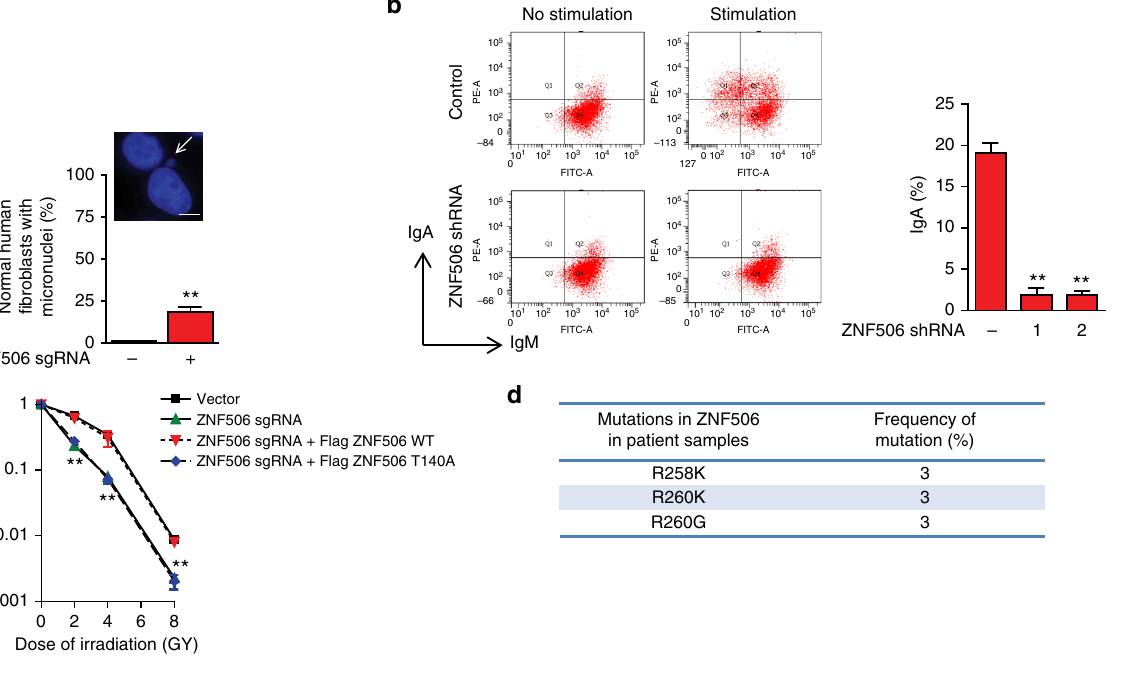
Mutations in ZNF506 in patient